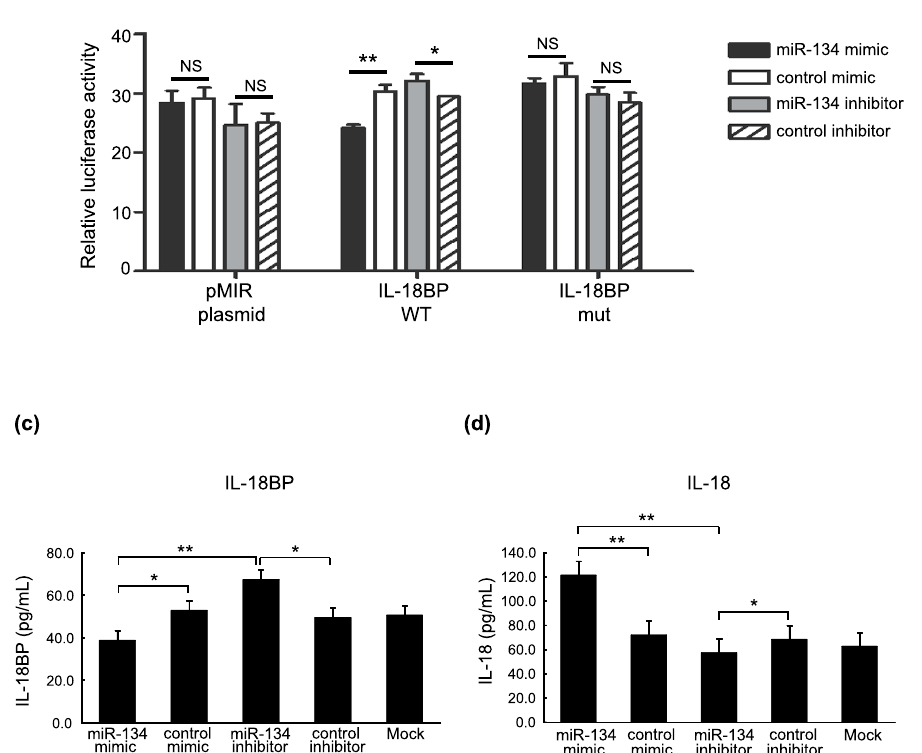
Figure 3. MicroRNA-134 (miR-134) targets IL-18 binding protein (IL-18BP). ( a ) The potential target for miR- 134 was IL-18BP. Sequence alignment of miR-134 with reverse complementary IL-18BP (http://www.microrna. org). ( b ) 293 T cells were co-transfected with IL-18BP 3 ′ UTR wild type (WT), IL-18BP 3 ′ UTR mutant or empty pMIR-REPORT vector and pTK-RL plasmid, together with miR-134 mimic/mimic control or miR-134 inhibitor/inhibitor control. After 36 h, luciferase activities were measured and normalized by Renilla luciferase activity. Data are presented as mean ± SEM. * P < 0.05, ** P < 0.01. NS, non-statistical significant. Comparison of supernatant levels of IL-18BP ( c ) or IL-18 ( d ) released in THP-1 cells transfected with miR-134 mimic, miR- 134 inhibitor, mimic/inhibitor control, or non-transfection cells (mock). Data are presented as mean ± SEM. * P < 0.05, ** P < 0.01, versus miR-134 inhibitor, mimic/inhibitor control, or non-transfection cells (mock), determined by the Student’s